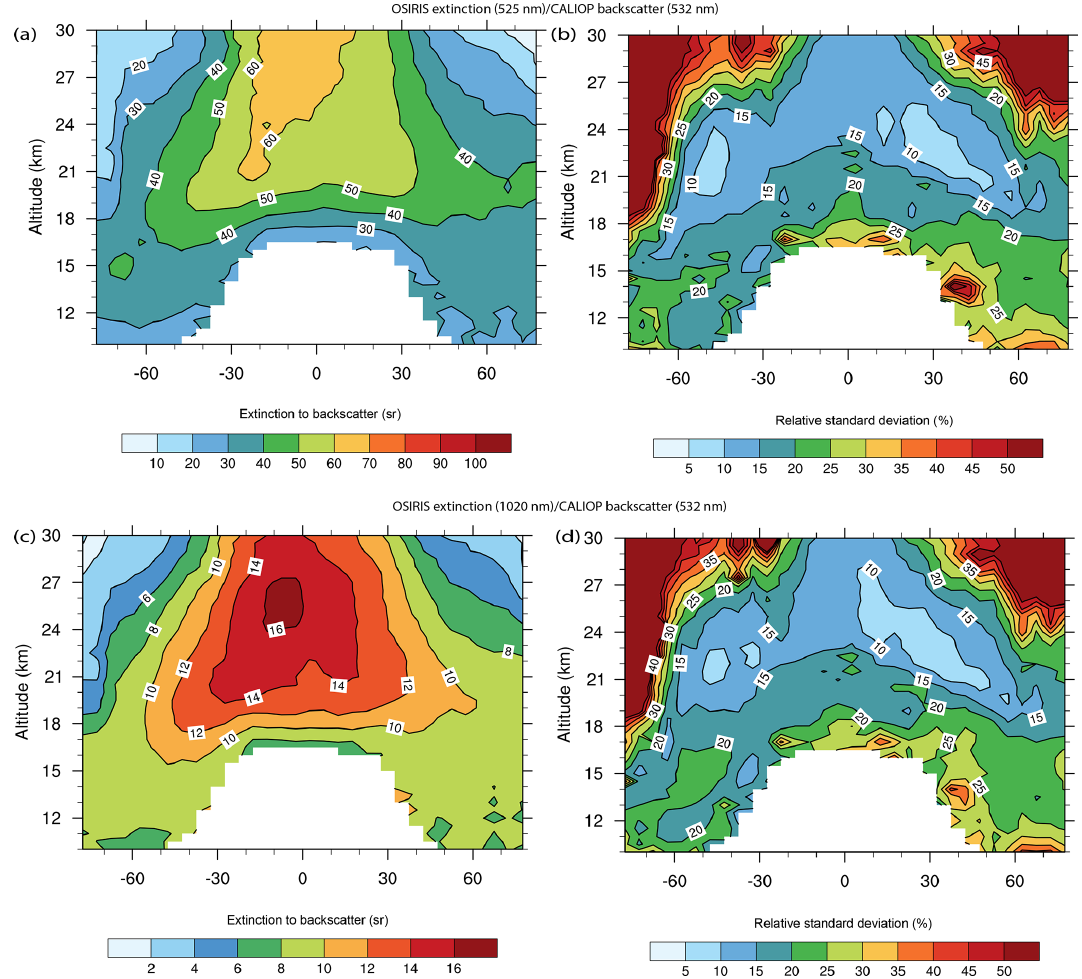
Figure 9. Altitude–latitude dependence of median annual OSIRIS extinction to 532nm backscatter ratio (OSIRIS/CALIOP) for the overlap period (2006–2017). (a) OSIRIS 525nm extinction to CALIOP 532 backscatter ratio (SF); (b) relative standard deviation of (a) is computed at each grid point with respect to the median value in percent. Panels (c) and (d) are the same as in panels (a) and (b) but using OSIRIS 1020nm